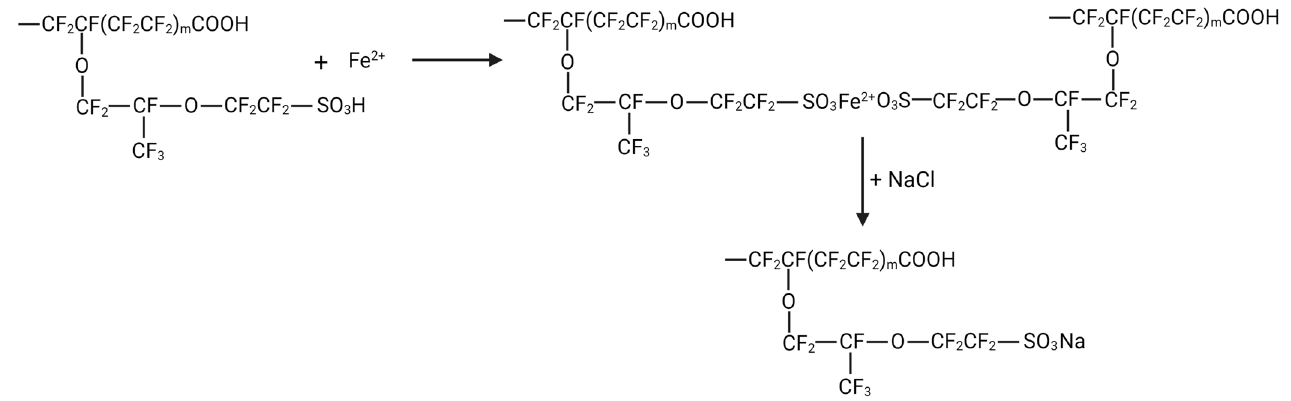
Figure 7. The schematic mechanism of ion exchange of Nafion membrane with Fe 2+ followed by replacement of Fe 2+ with 2 Na + during Fenton’s test in the presence of NaCl.